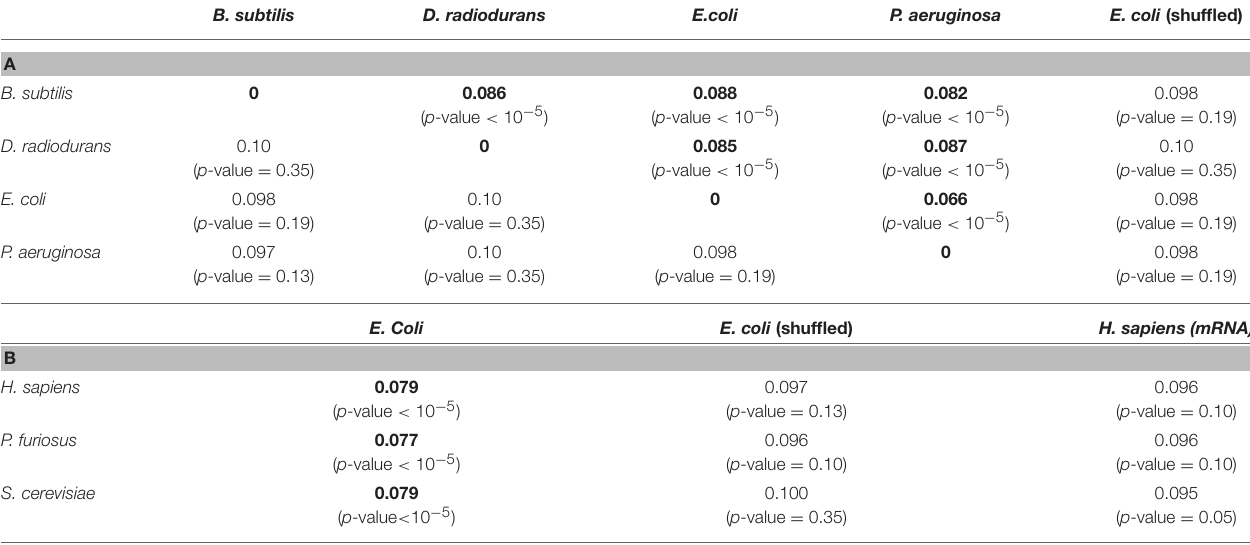
TABLE 1 | Conservation of ribosomal